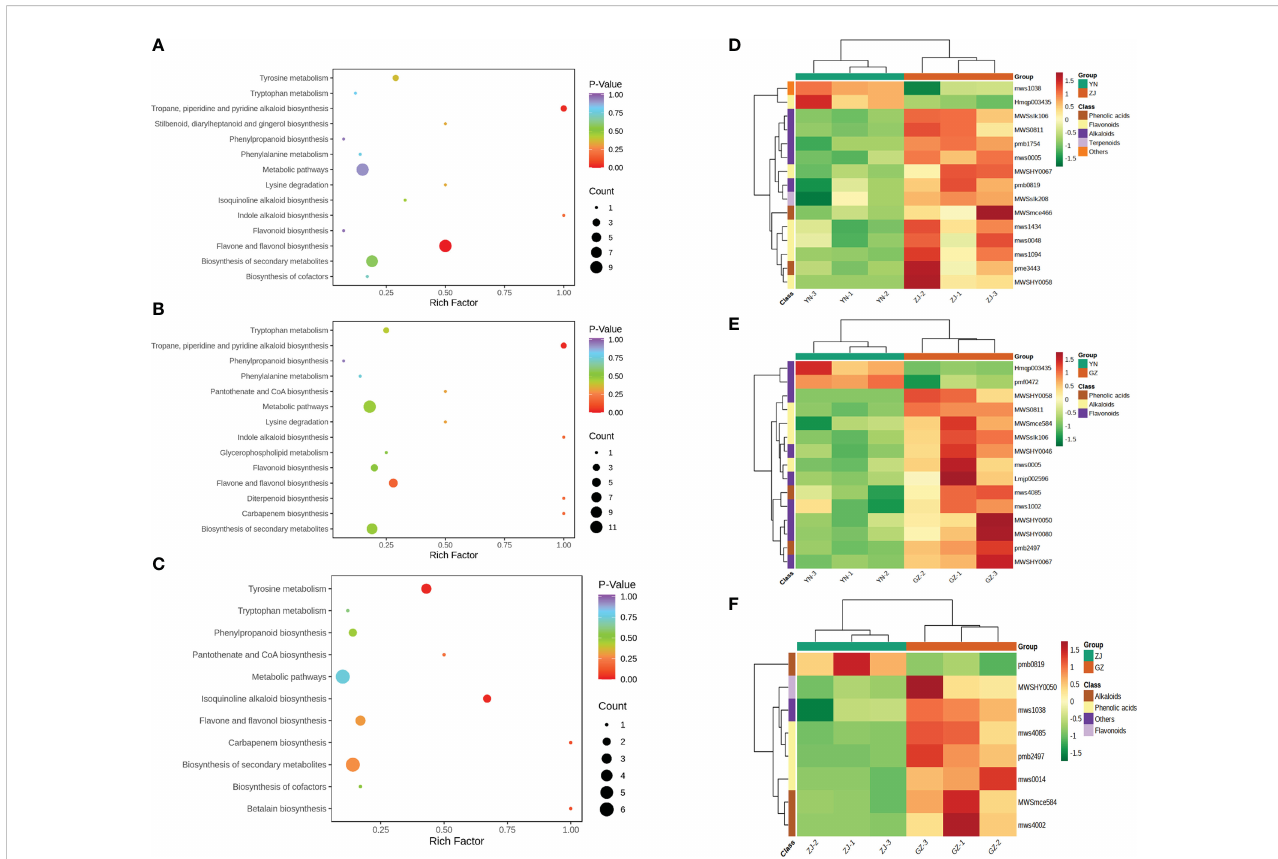
FIGURE 5 KEGG enrichment maps and heatmaps analysis of differential metabolites for three comparison groups (YN vs. GZ, YN vs. ZJ, ZJ vs. GZ). (A – C) , KEGG enrichment maps of differential metabolites in different pairwise comparisons: (A) YN vs. ZJ; (B) YN vs. GZ; (C) ZJ vs. GZ. D-F, Heatmaps of hierarchical cluster analysis (HCA): (D) YN vs ZJ; (E) YN vs GZ; (F) ZJ vs GZ. (A – C) The abscissa represents the enrichment factor of the pathway and the ordinate shows the names of pathways. The color of the dot represents the p-value, and the deeper the red of the dot, the stronger the enrichment effects. The size of points represents the number of metabolites enriched in the pathways. (D – F) The abscissa is used to display the names of samples, and the ordinate on the right is used to display the names of differential metabolites. The deeper the red color, the higher the content of the metabolites; the deeper the green color, the lower the content of the metabolites. The abscissa is the name of the sample and the ordinate is the differential metabolite. Different colors in the heat map represent the relative content of the differential metabolite. The value obtained after normalization re fl ects the relative content (red represents high content and green represents low content).